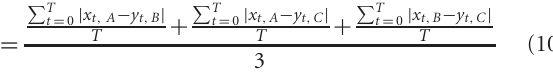
Figure 7B , the neural dynamics of the original task before